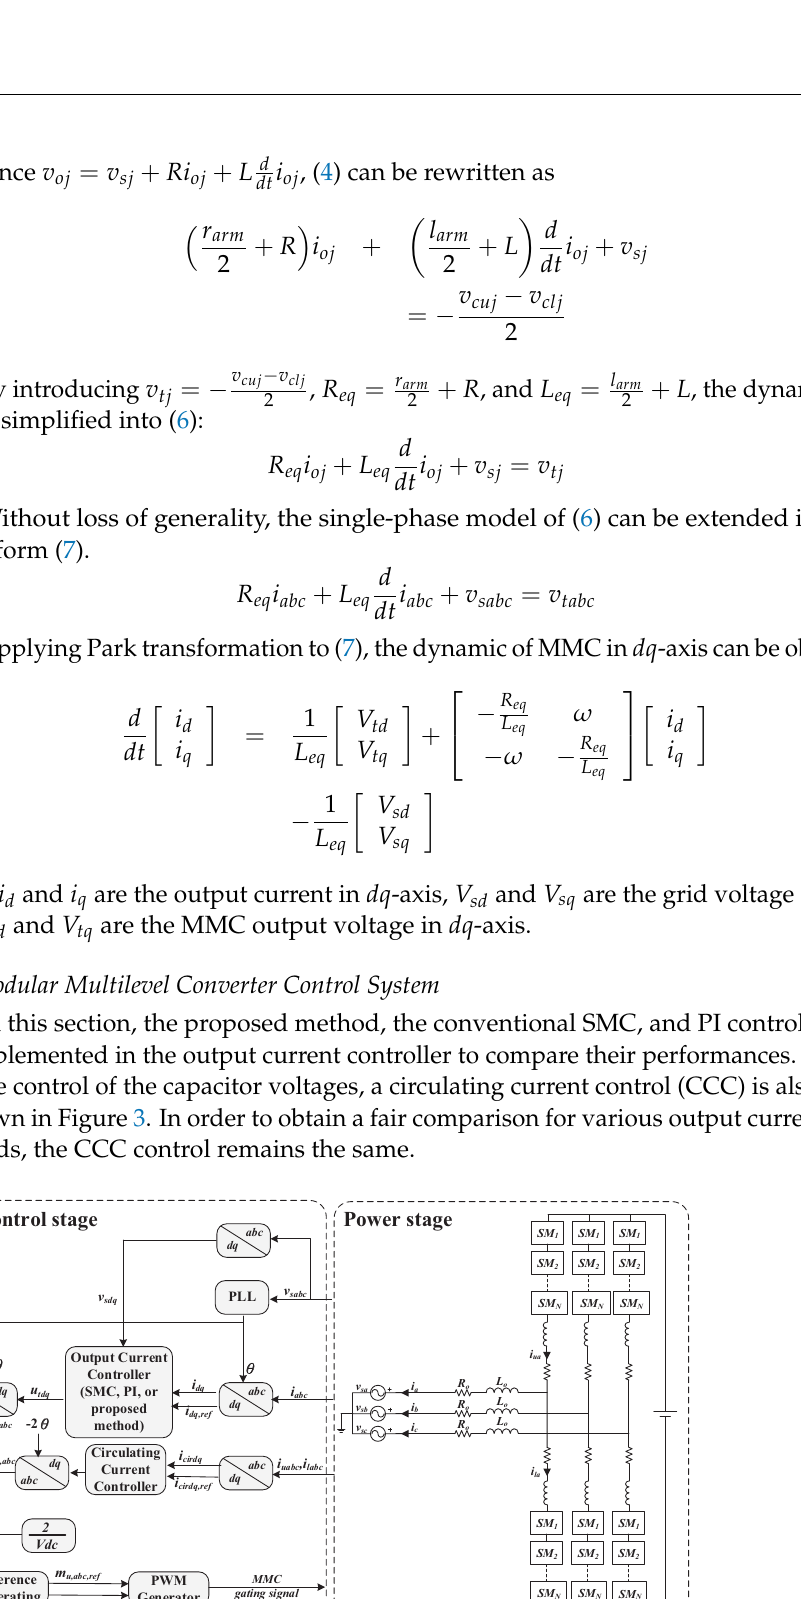
circulating current on the output